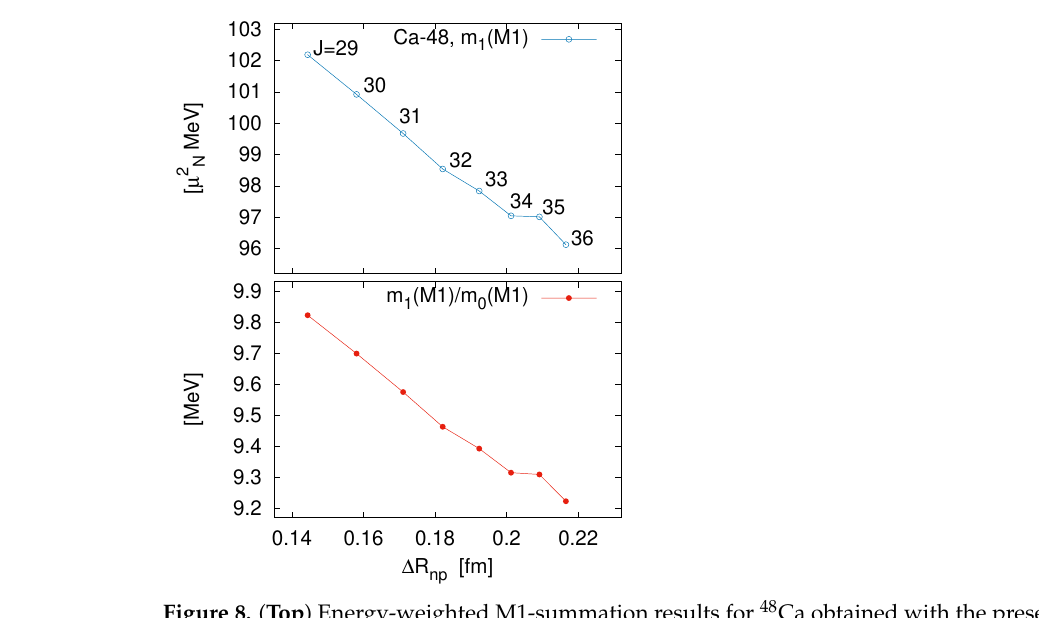
Figure 8. ( Top ) Energy-weighted M1-summation results for 48 Ca obtained with the present DD-PC interactions. ( Bottom ) Centroid energy of M1 transition, ¯ E ≡ m 1 ( M1 ) / m 0 ( M1 ) .